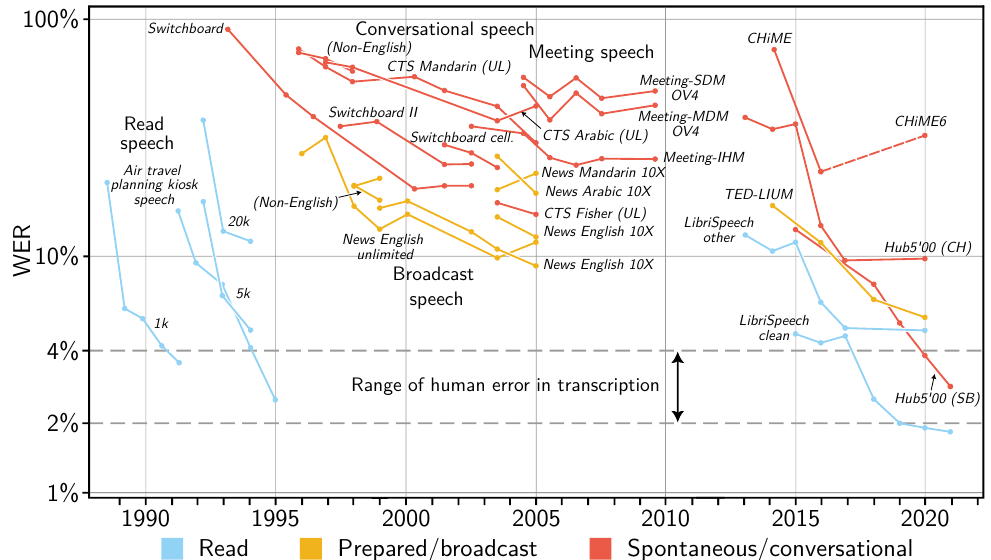
Figure 2. The historical progress of speech-to-text benchmarks, extended from Ajot and Fiscus [35] (as cited in Valenta and Šmídl [28]). We have added new points after 2009 from collected benchmark results of deep learning methods trained on newer data sets, using the best results for each year as listed in Synnaeve [36]. Of these, LibriSpeech is (mostly) read speech; TED-LIUM contains prepared and spontaneous speech; HUB5’00 is built from Switchboard and CallHome, which are types of conversational speech; CHiME and its successor CHiME6 consist of noisy low-resource conversational speech. We can see how performance gains become flatter the more spontaneous the speaking style